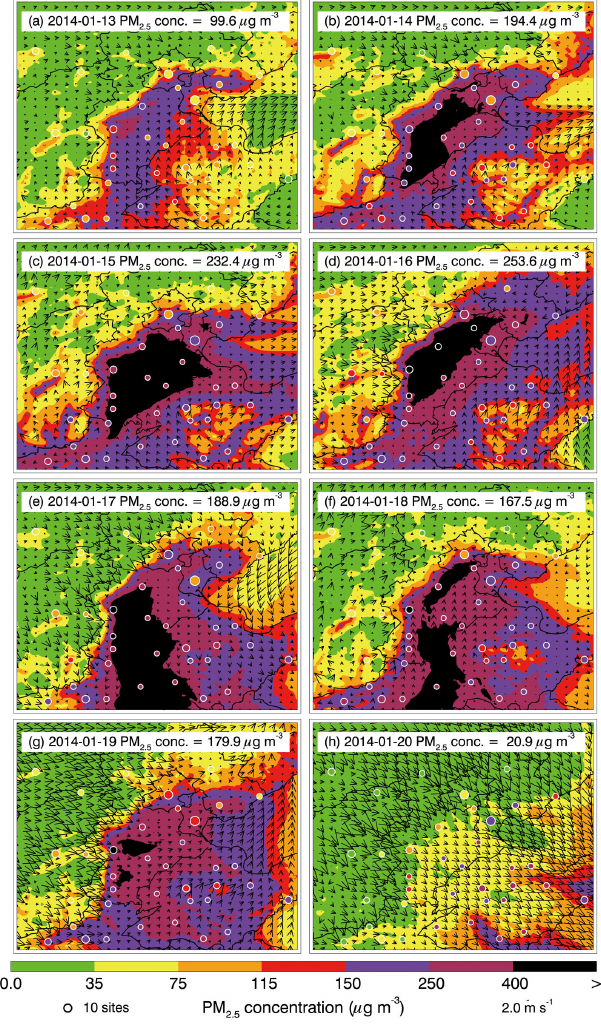
Figure 8. Same as Fig. 7 but for the ensemble member of 16 with the highest simulated PM 2 . 5